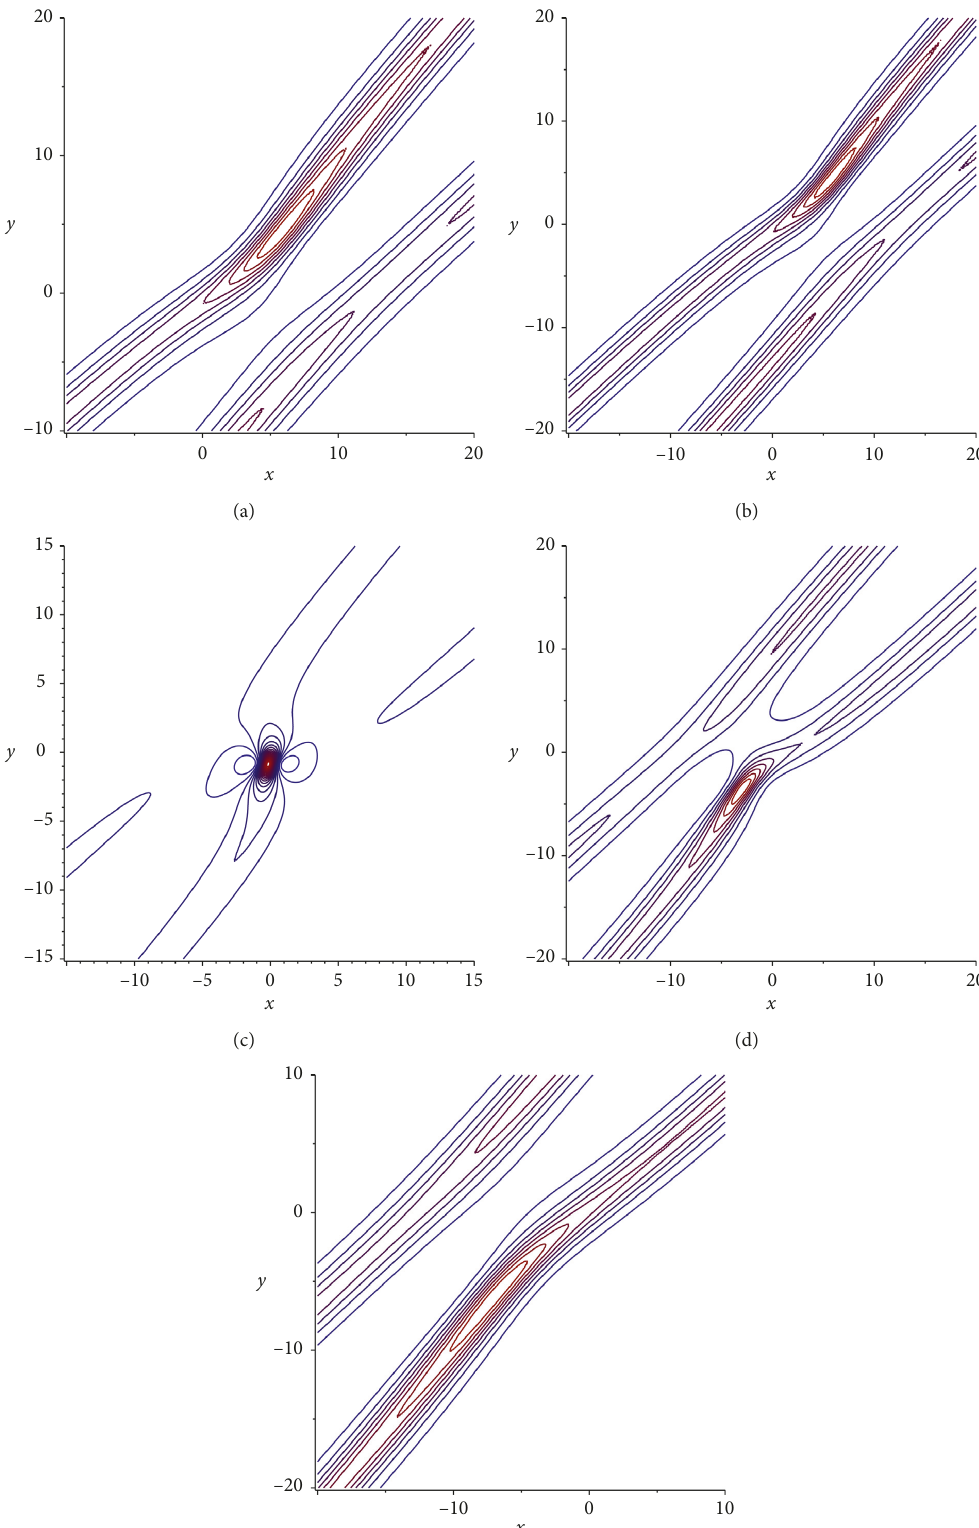
Figure 6: Density plot of the interaction solution between lump and stripe solitons (30) with z � 0 and different time t : (a) t � − 6; (b) t � − 3; (c) t � 0; (d) t � 3; (e) t �